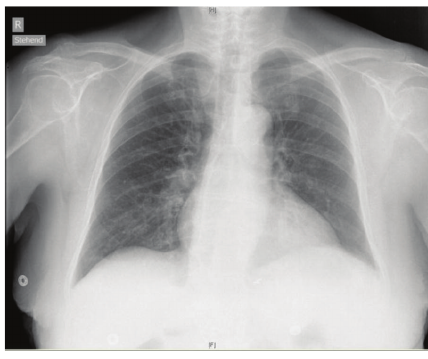
Figure 1: Chest X-ray anteroposterior at admission (sitting).